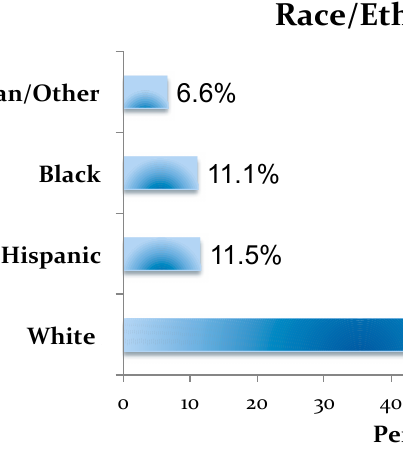
Figure A3. Race and Ethnicity differences among SIH cases.